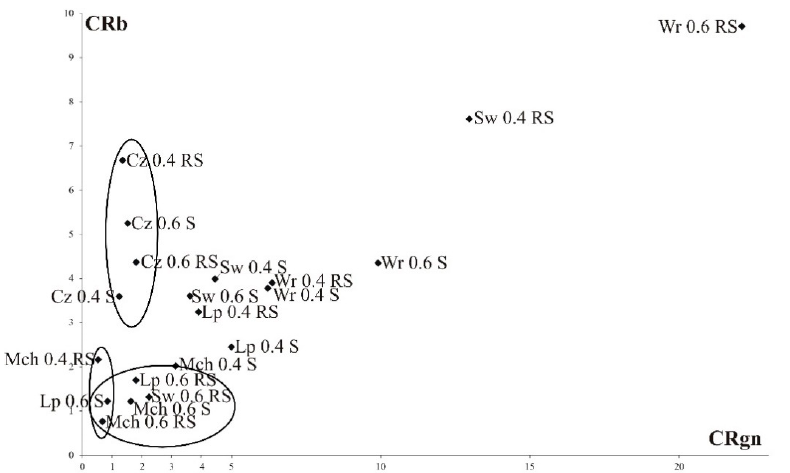
Figure 4. The distribution of sites × winter wheat proportion in the mixture × bentgrass biotypes for the competitive ratio indices calculated for the relative number of grains (CRgn) and relative biomass of plant (CRb) in 2017–2018. Legend: Lp—Lipnik, Mch—Mochełek, Cz—Czesławice, Sw—Swojczyce, Wr—Wrocław (sites of experiments); RS—bentgrass biotype with a single resistance; S—susceptible biotype.